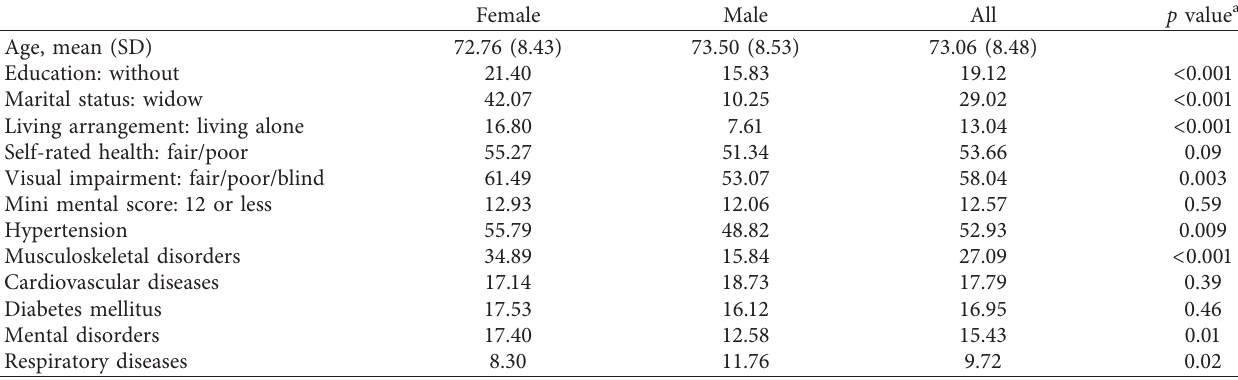
Table 1: Baseline characteristics by sex (SABE study, municipality of São Paulo, 2000).